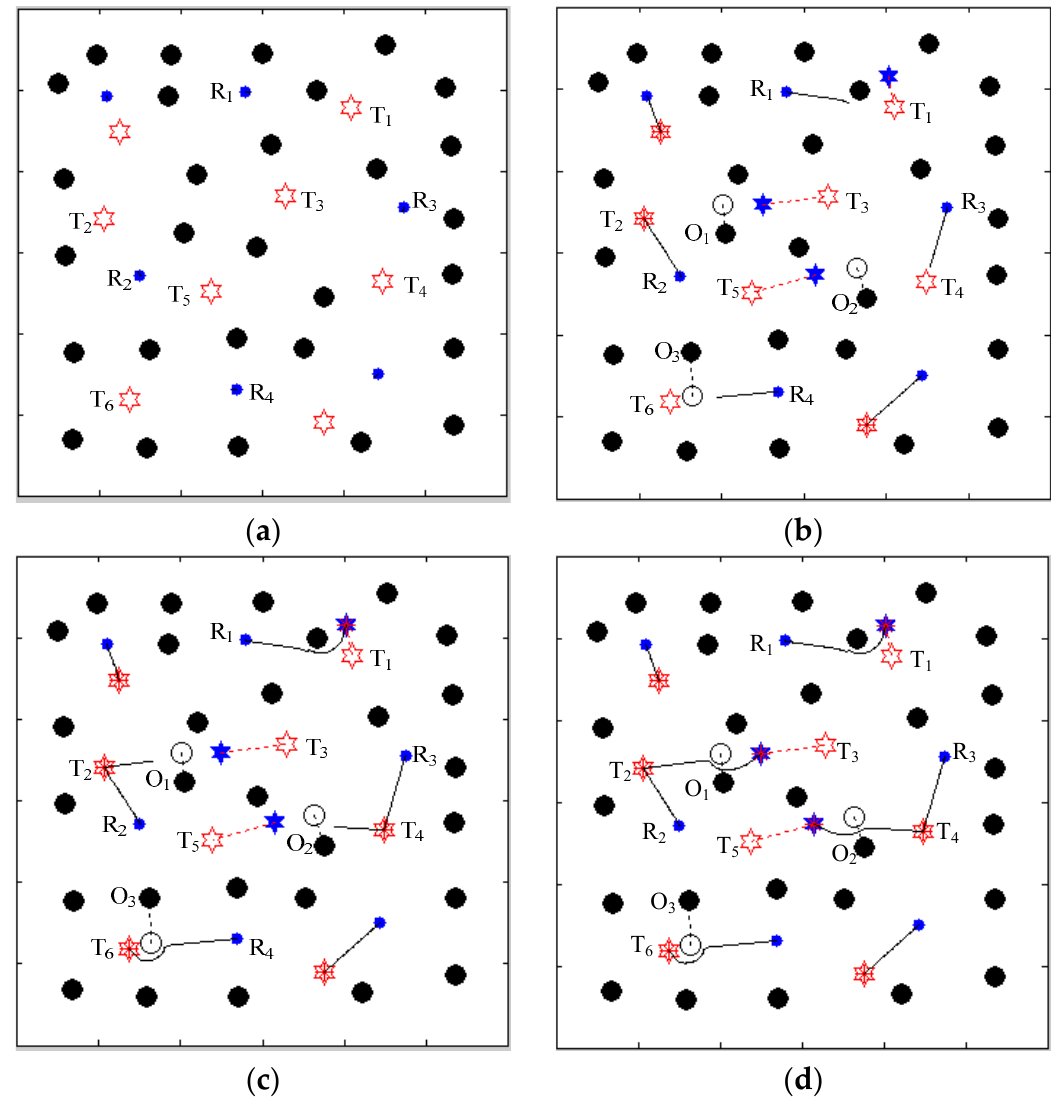
Figure 4. Trajectories of robots searching targets, where some obstacles and some tasks are movable. ( a ) t = 0, ( b ) t = 50, ( c ) t = 90, ( d ) t = 140.